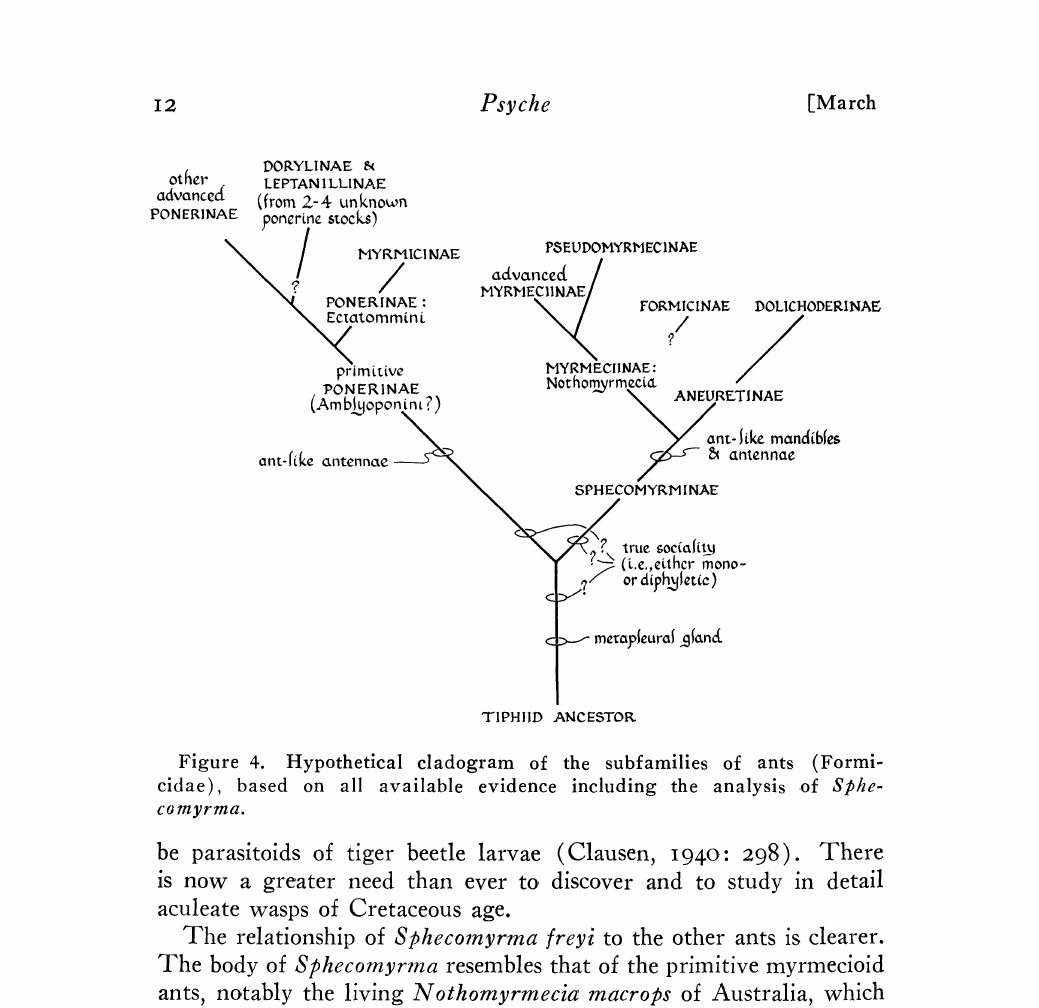
Figure 4. Hypothetical cladogram of the subfamilies of ants (Formi- cidae), based on all available evidence including the analysis ,of Sphe-